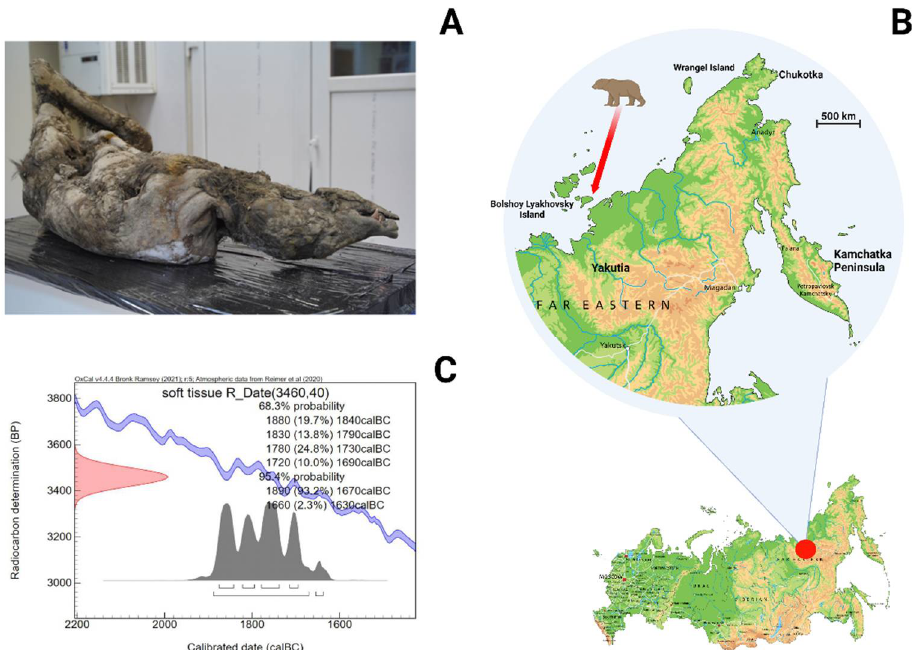
Figure 1. Brown bear specimen. ( A ) Frozen carcass of a brown bear fossil (MM-F54) in the Laboratory of P.A. Lazarev Mammoth Museum of the Research Institute of Applied Ecology of the North. ( B ) Geographical map showing the place where the brown bear carcass (MM-F54) was collected. ( C ) Calibrated 14 C date for Holocene brown bear specimen, which was collected on Bolshoy Lyakhovsky Island (Yakutia, Russia).